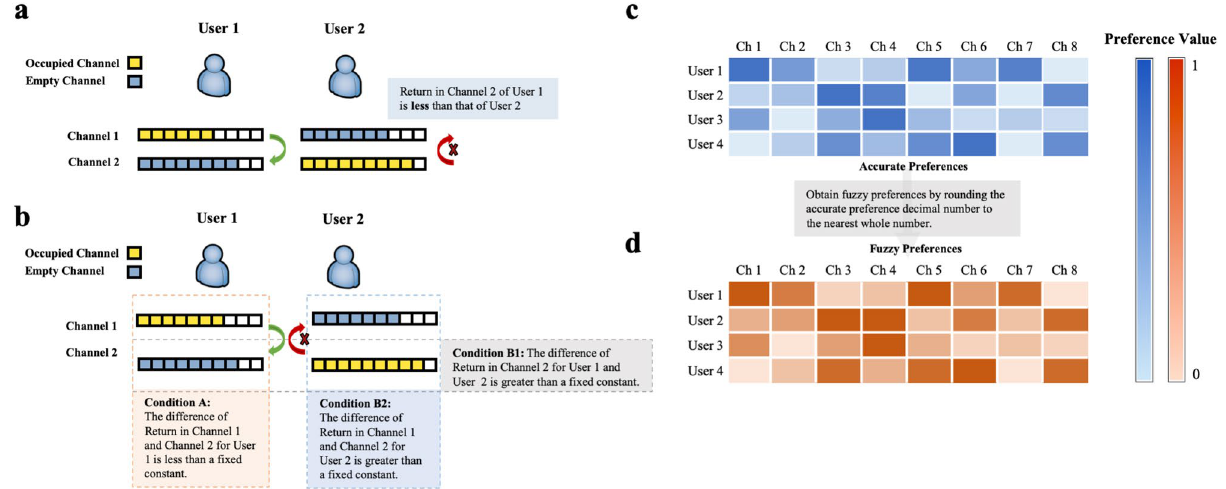
Figure 2. SCA and FSCA instructions for two users and eleven channels. ( a ) The SCA state where user 1 is willing to exchange, and user 2 is reluctant to exchange. ( b ) The SCA state where Conditions A and B1 are satisfied but Condition B2 is not. ( c ) The users’ preferences with specific cognition ranging from 0 to 1. ( d ) The users’ preferences with vague cognition obtained from (c) .